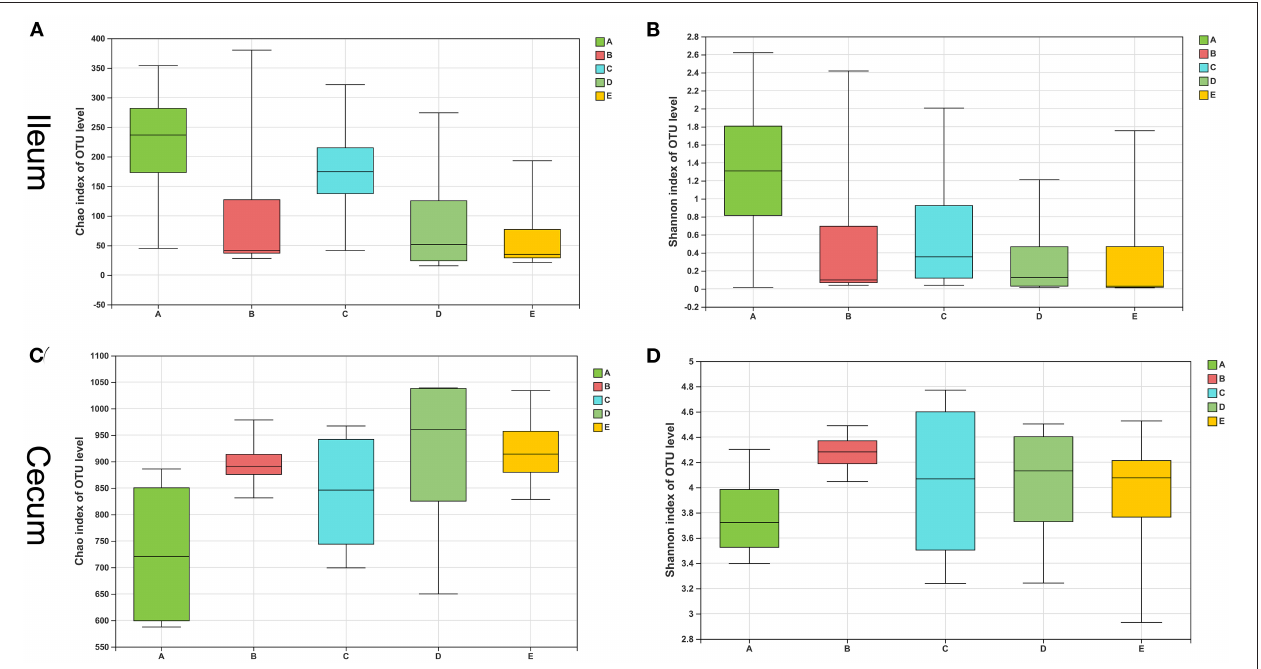
FIGURE 2 | Alpha-diversity of intestinal bacterial community of weaned piglets. (A) The bacterial richness in the ileum estimated by the Chao1 value. (B) The bacterial diversity in the ileum estimated by Shannon index. (C) The bacterial richness in the cecum estimated by the Chao1 value. (D) The bacterial diversity in the cecum estimated by Shannon index.